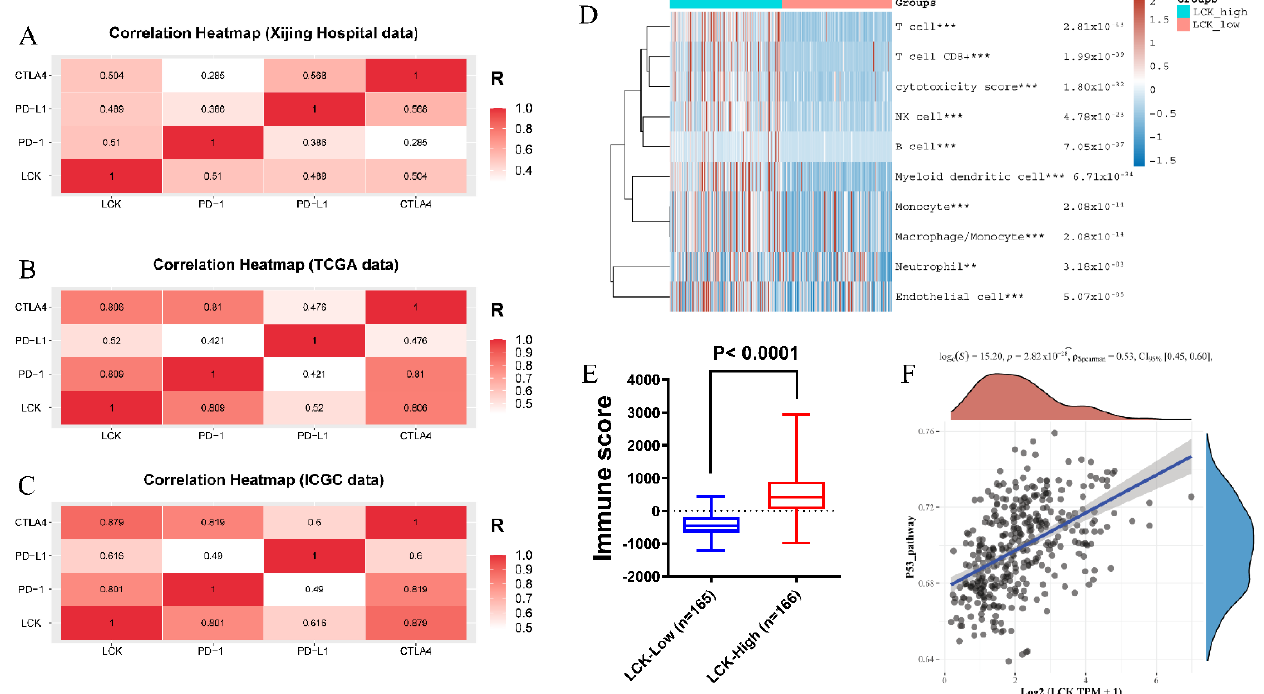
Figure 10. Correlation heatmaps of LCK expression and immune checkpoint expression from the Spearman correlation analysis: ( A ) Xijing Hospital data; ( B ) TCGA data and ( C ) ICGC data. ( D ) Using R software to draw the immune scoring heatmap based on the expression difference in LCK and MCP counter algorithm; ( E ) Box chart of immune score difference between different LCK expression groups. ( F ) Scatter plot of the correlation between LCK and the P53 signalling pathway. p < 0.001 = *** and p < 0.01 = **.